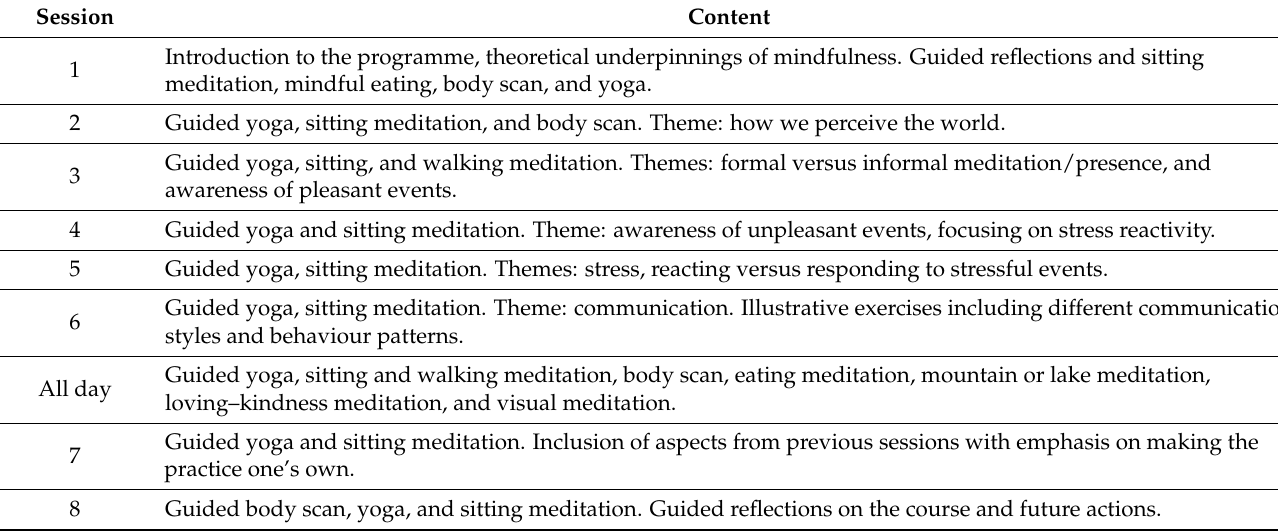
Table 2. Content of sessions in the MBSR